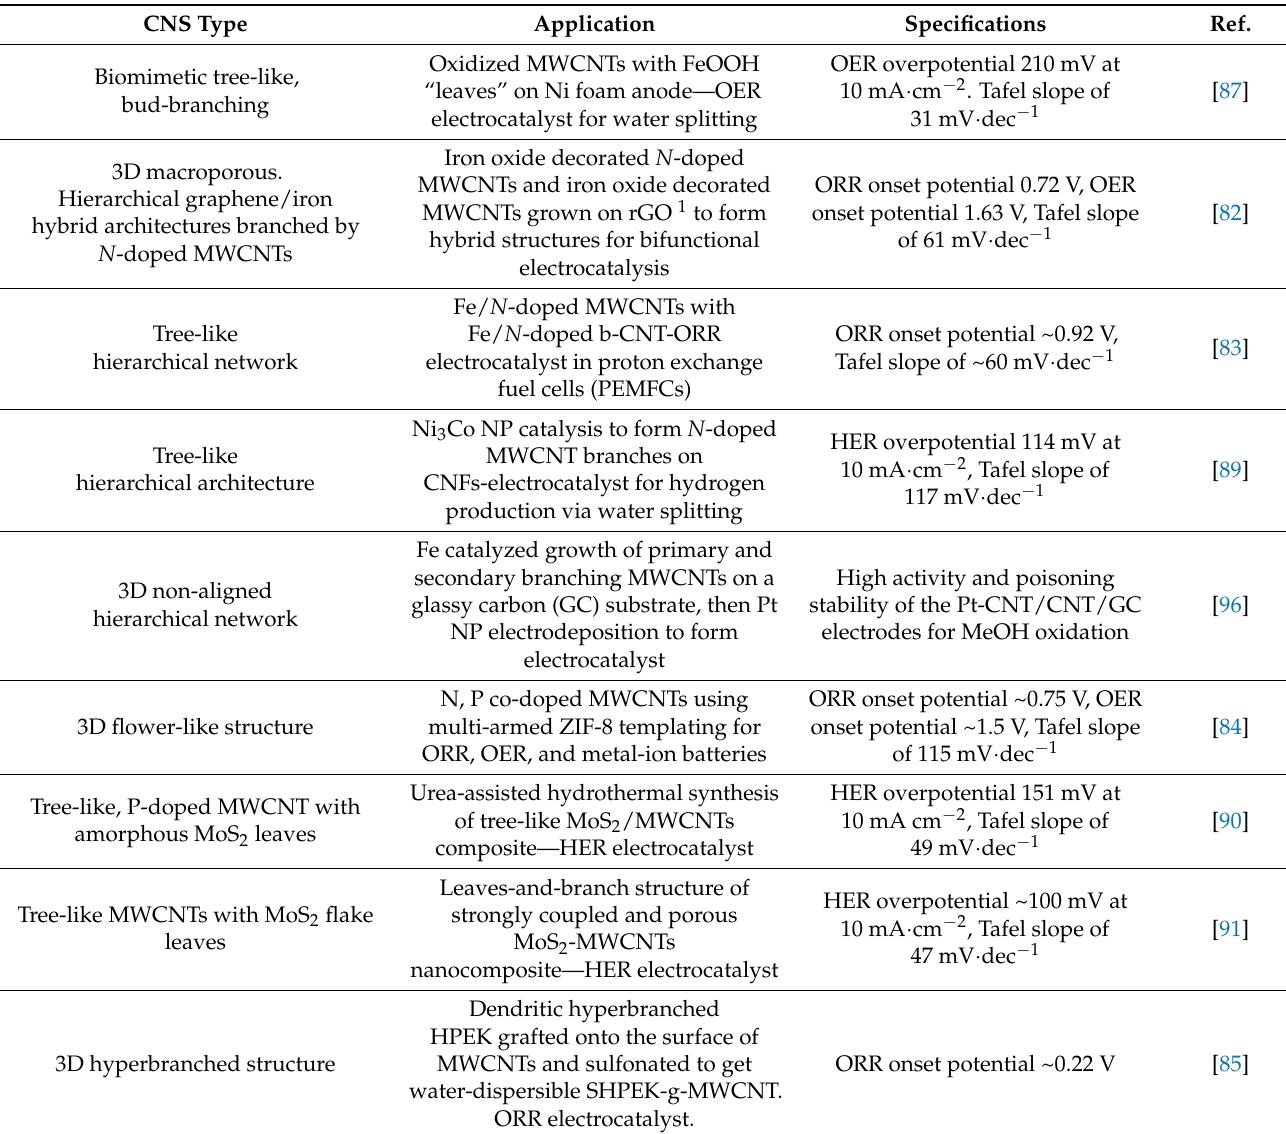
Table 2. Recent examples of branched CNSs used in